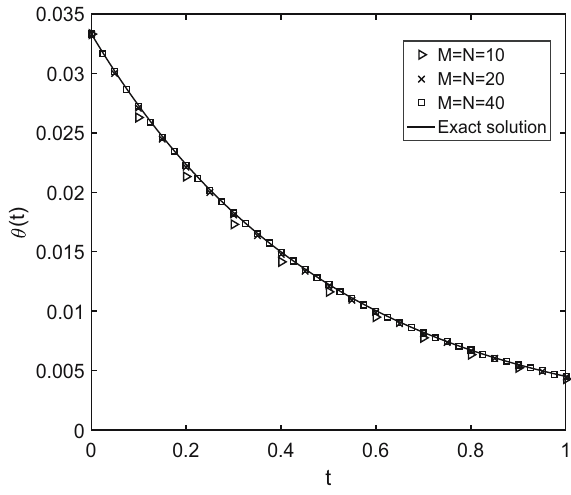
Figure 2: The exact ( 80 ) approximate ( ) θ t , for Example